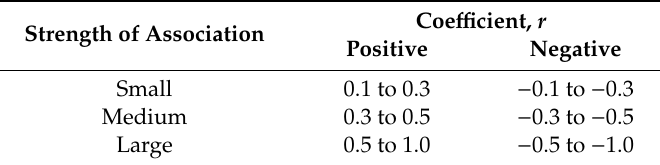
Table 3. Criteria for Strength of